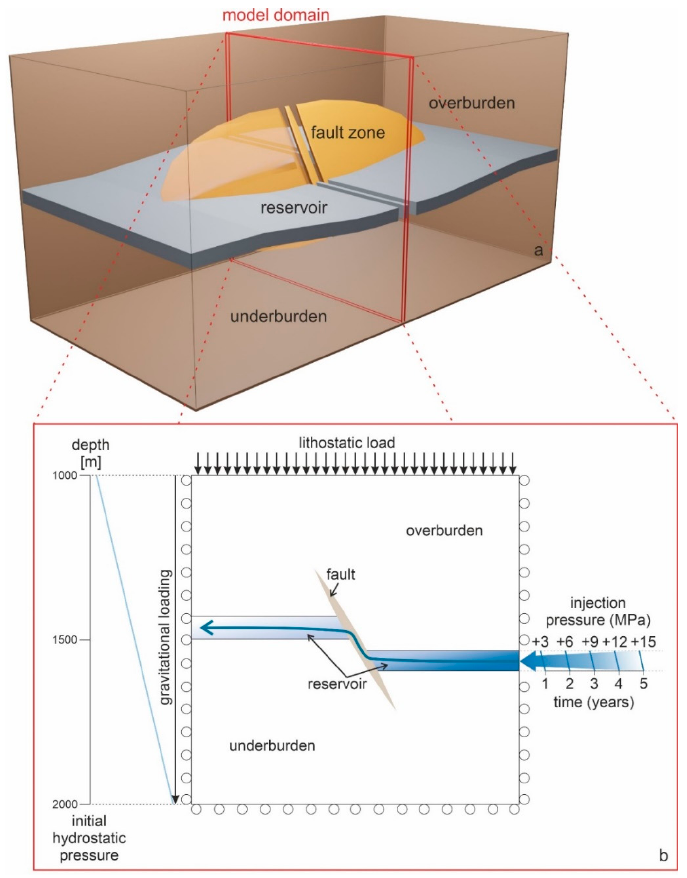
Figure 1. ( a ) A slice through a reservoir horizon displaced by the central part of an elliptical fault zone is the geological rationale for the 3D fault zone model as shown in the cartoon. ( b ) General model set-up for the hydro-mechanical simulations as well as initial and boundary conditions used.